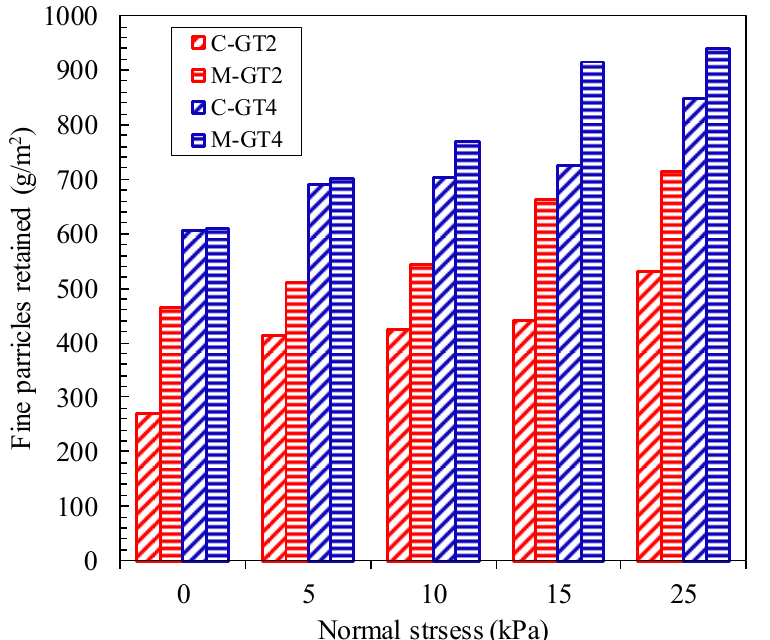
Figure 8. Relationship between fine particles retained and normal stress acting on soil–geotextile combinations.